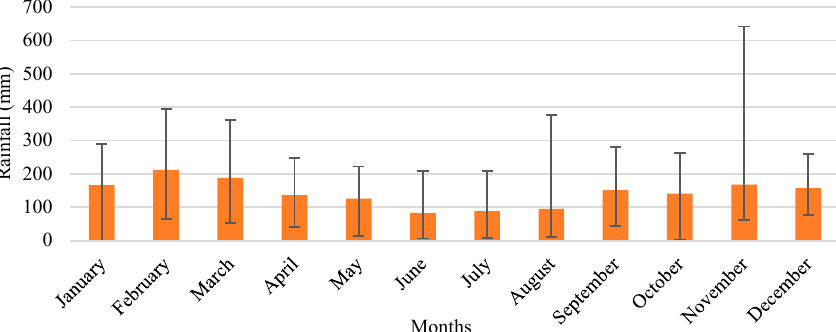
Figure 2. Monthly average, maximum and minimum rainfall in Florian ó polis from 2000 to